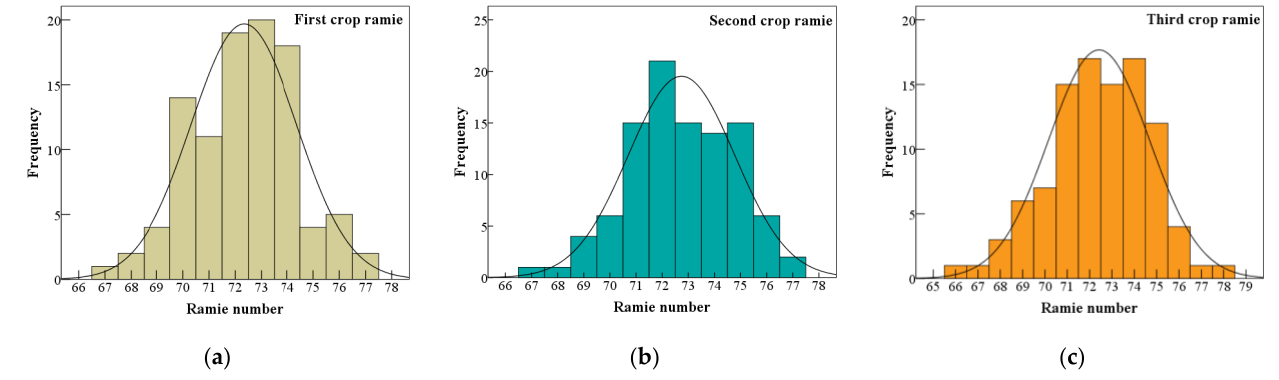
Figure 3. Histogram of three crops of ramie. ( a ) First crop ramie; ( b ) Second crop ramie; ( c ) Third crop ramie.